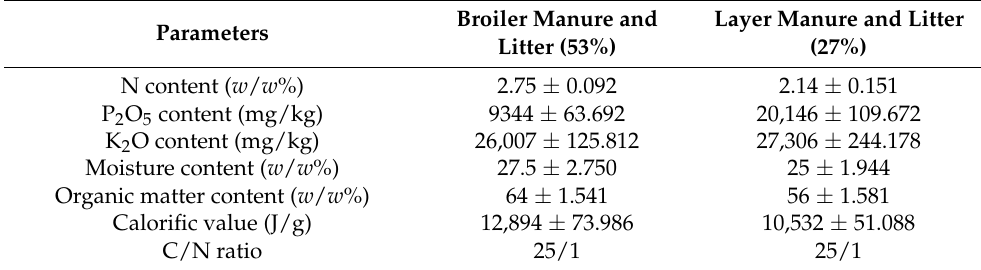
Table 1. Parameters of broiler and layer manure and litter.